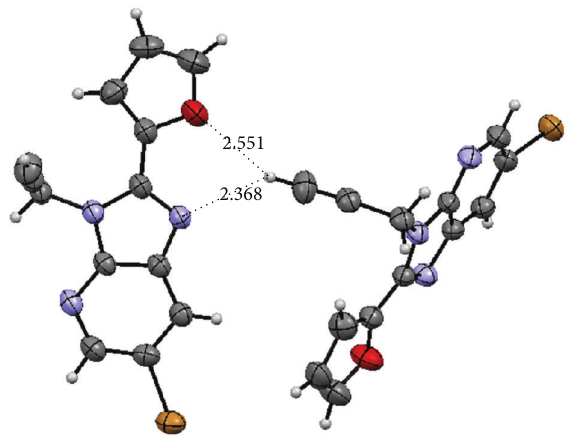
Figure 2: Intermolecular C–H ⋅⋅⋅ N and C–H ⋅⋅⋅ O interactions for compound 1 .